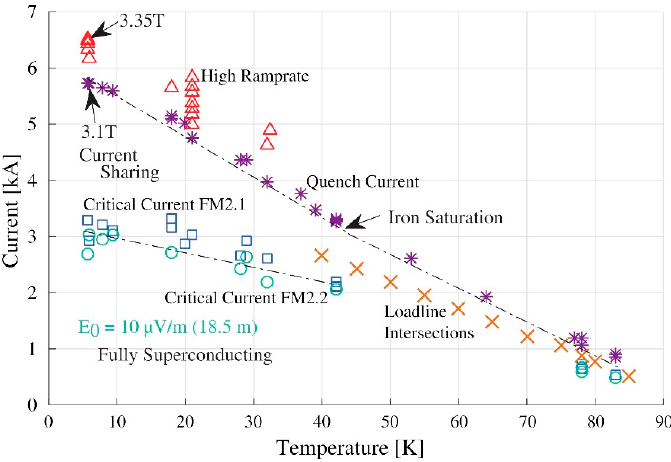
Figure 24. First test of the AB dipole FeatherM2.1-2 (quench current vs. operating temperature). Magnet excitation was carried out at a standard ramp rate of about 10 A/s, except when indicated as high ramp rate (hundreds A/s, red triangles). The region dominated by current sharing is indicated (between the two dot-dashed lines). Courtesy of J. van Nugteren and H. Bajas (CERN). A full analysis of the test results is reported in [83,84]. The main points are: